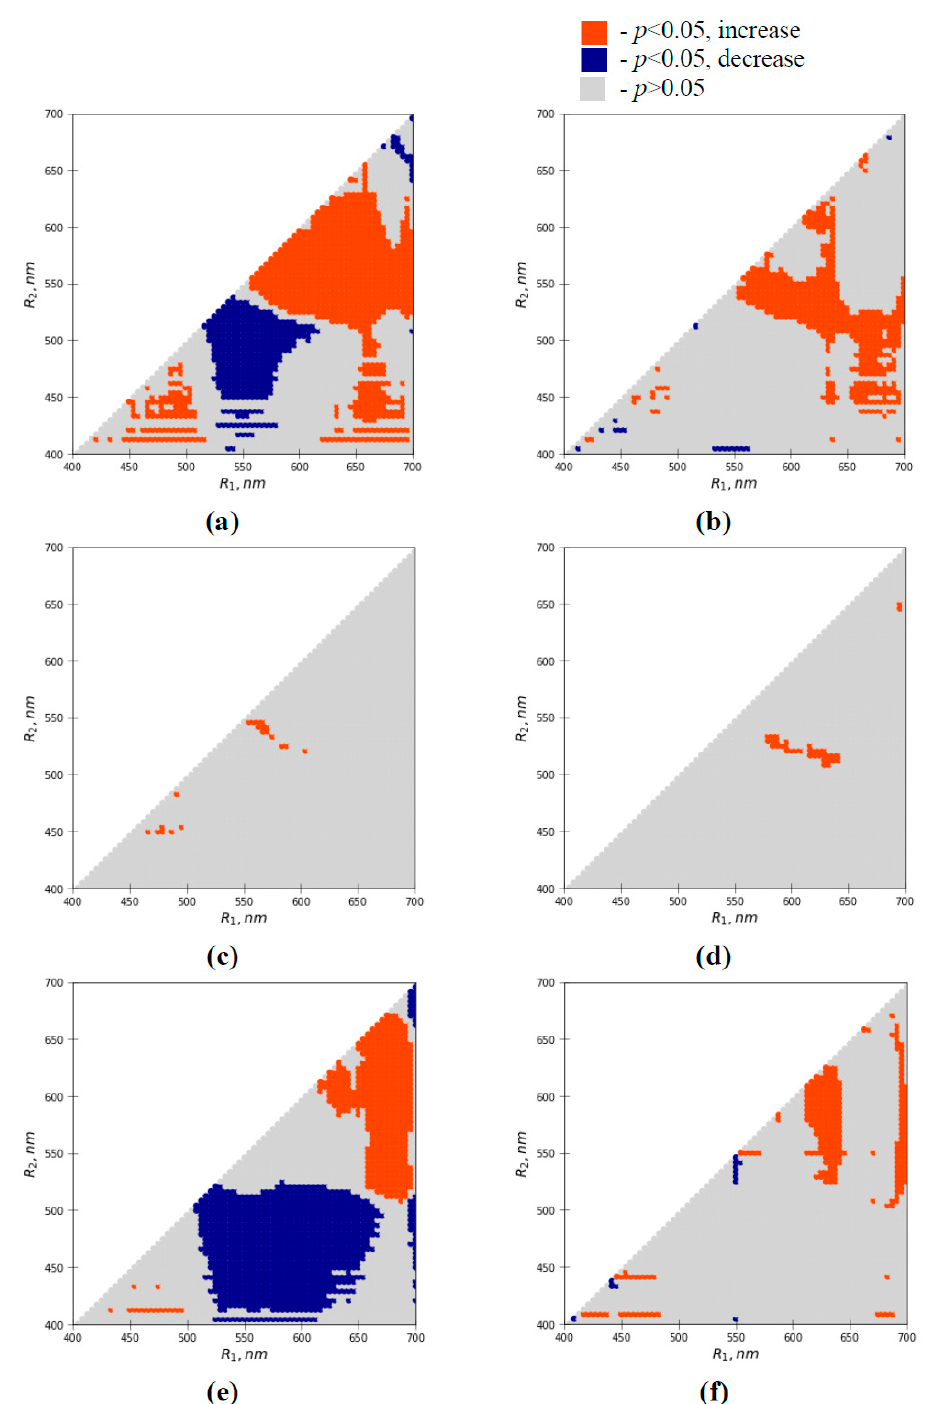
Figure 7. Heatmaps of significances and directions of heating-induced changes in absolute values of RIs in pea leaves in ( a ) 1 h and ( b ) one day after the heating, wheat leaves in ( c ) 1 h and ( d ) one day after the heating, and pumpkin leaves in ( e ) 1 h and ( f ) one day after the heating. RIs were calculated based on the equation RI = I I(R 2 ) are intensities of reflected light at different narrow spectral bands (averaged for 3 nm). The Mann–Whitney U test was used for p calculations.